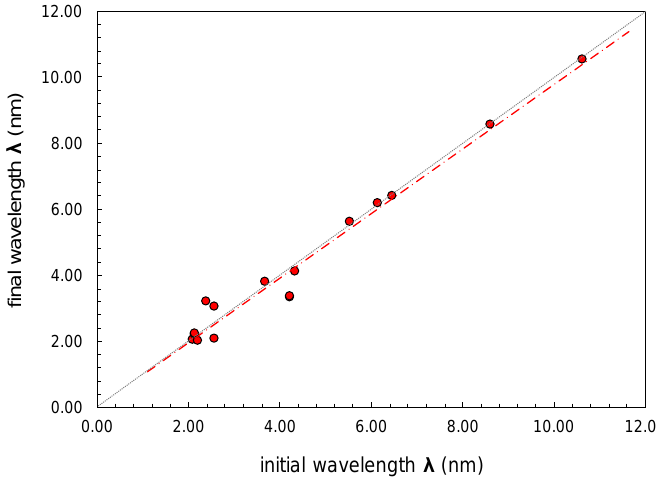
Figure 2. The final wavelength of the composition modulation after long-term aging is plotted as a function of the initial (as-deposited) wavelength for each Cu-Ni(Fe) nanolaminate. The amplification factor ( R ) for each nanolaminate is computed from the normalized, integrated intensity values and the 2θ position of each diffraction peak. The ratio between the normalized satellite and Bragg peaks is compared between the as-deposited condition, and after 30 years aging at room temperature. An initial nonlinear response [19,22] in the ln-scale, normalized-satellite intensity variation with anneal time, i.e., amplification factor R , that can occur from a strong composition dependence in Cu-Ni [27,28] is not anticipated in this study since the growth of the